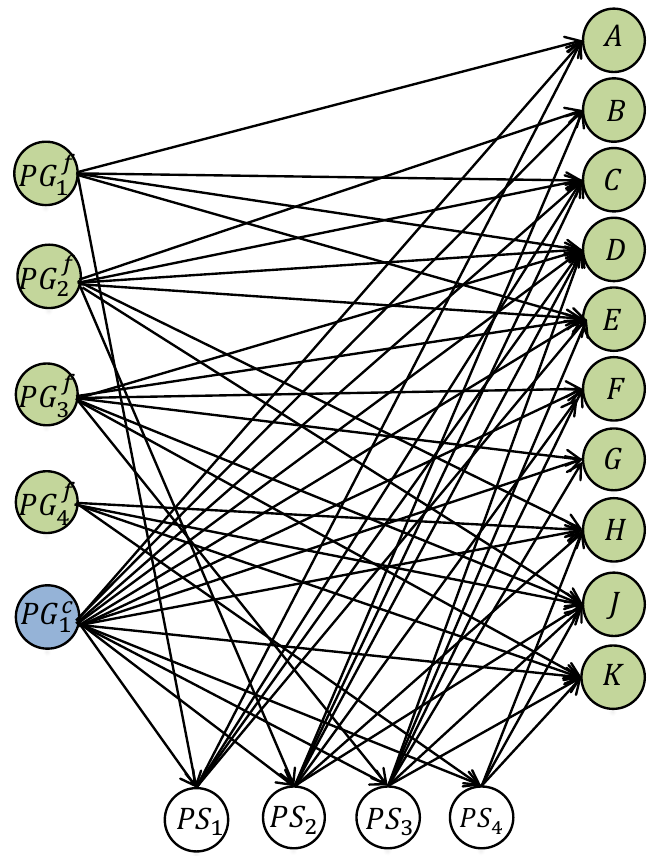
Figure 17. Graph representation of zone based